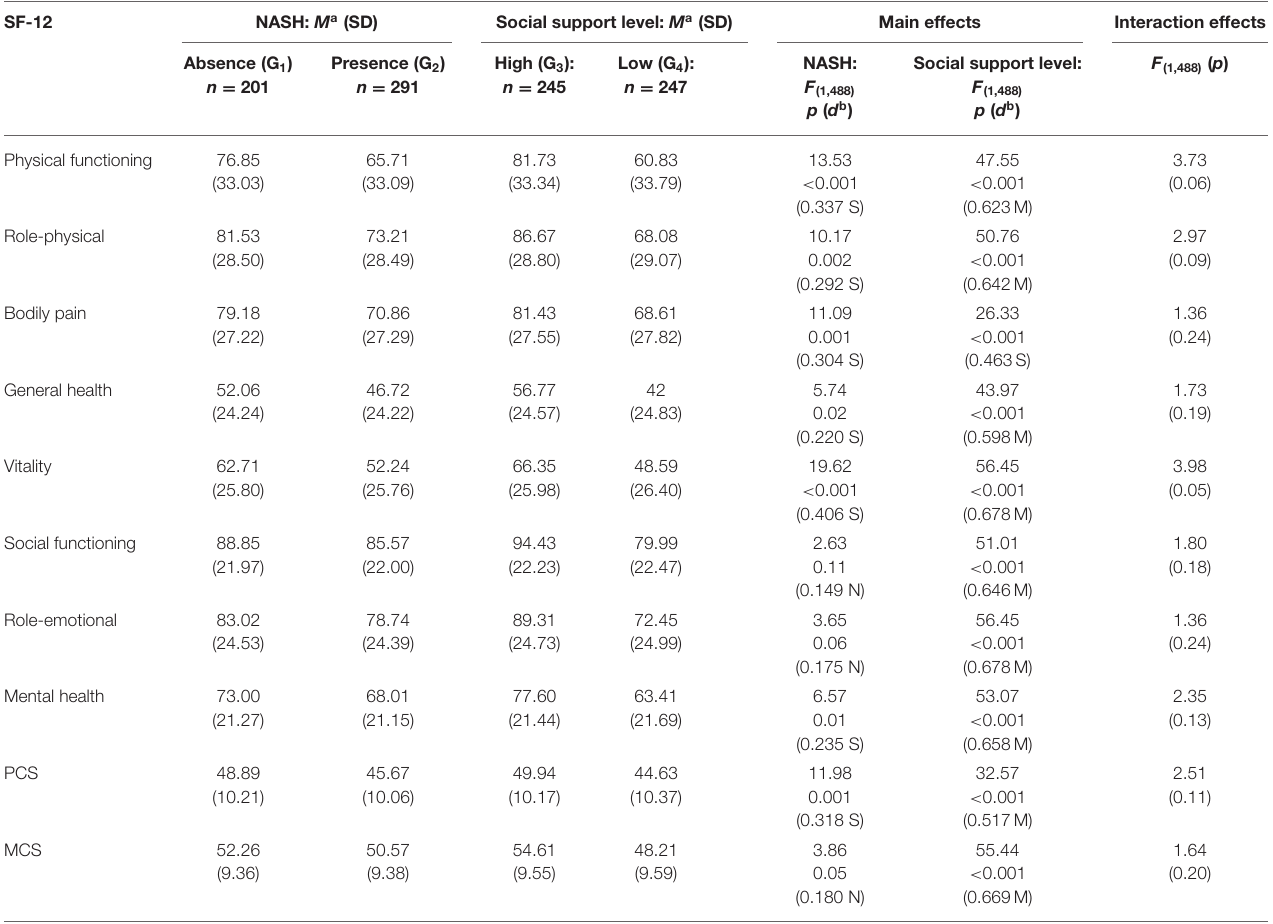
TABLE 1 | Quality of life (SF-12) of non-alcoholic fatty liver disease (NAFLD) patients based on non-alcoholic steatohepatitis (NASH; absence and presence) and social support level (high and low) variables.